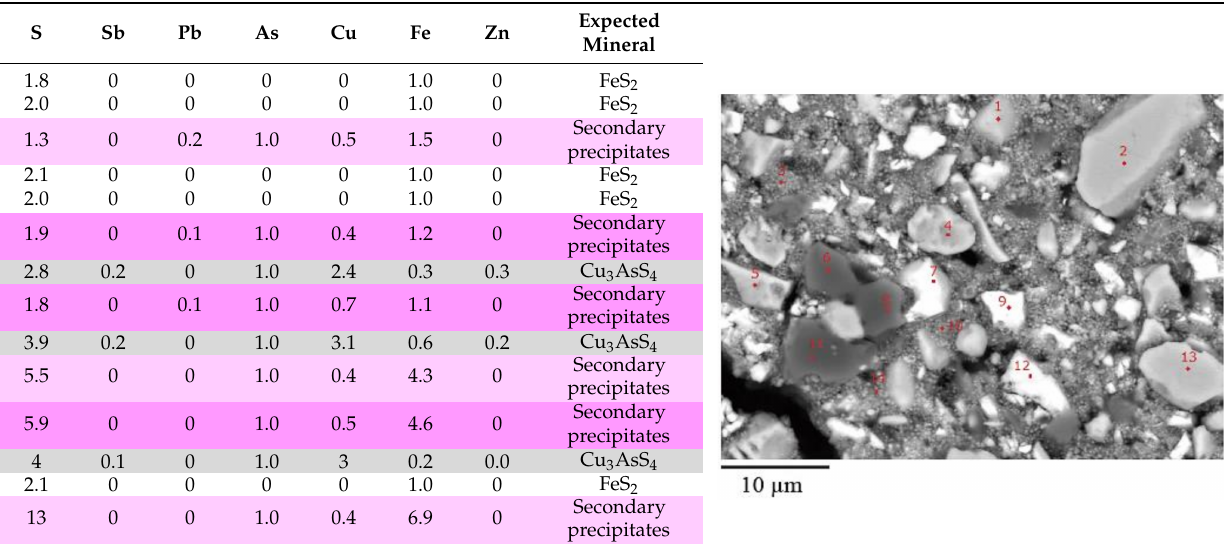
Table 2. Backscattered electron image of DC-III residue bioleached for 60 days without AC. Points 1–14 indicate the beam spot positions for the quantitative analysis. Expected mineral types: FeS 2 (no color); Cu 3 AsS 4 (grey); secondary As-precipitates (fine particles in light pink; large gel-like particles in dark